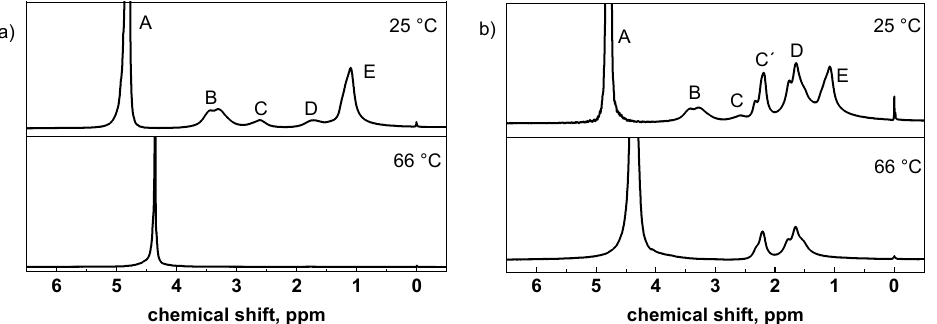
Figure 1. Temperature dependence of the swelling ratio for the SN-D and DN-DA hydrogels.